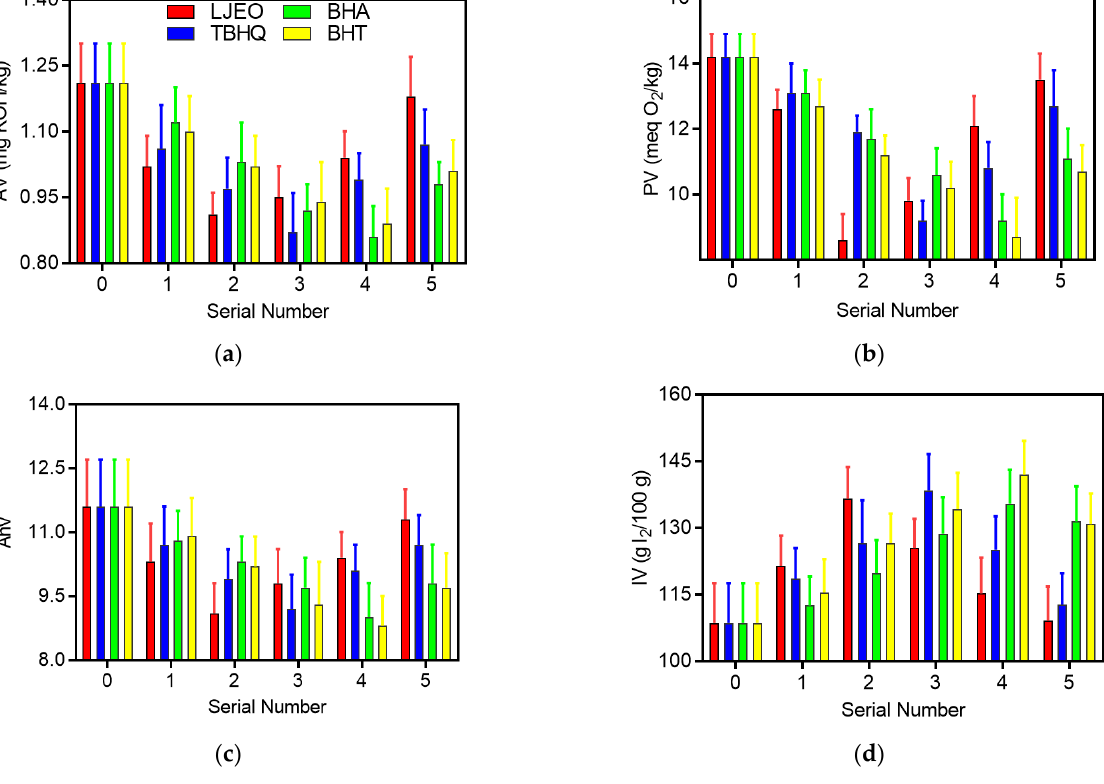
Figure 1. The acid value (AV, ( a )), peroxide value (PV, ( b )), p ‐ anisidine value (AnV, ( c )) and iodine value (IV, ( d )) of sunflower oil added by LJEO, TBHQ, BHA, and BHT at 0.03, 0.06, 0.09, 0.12, and 0.15 g/kg during the frying, respectively. Values are expressed as means ± SD (n = 10).